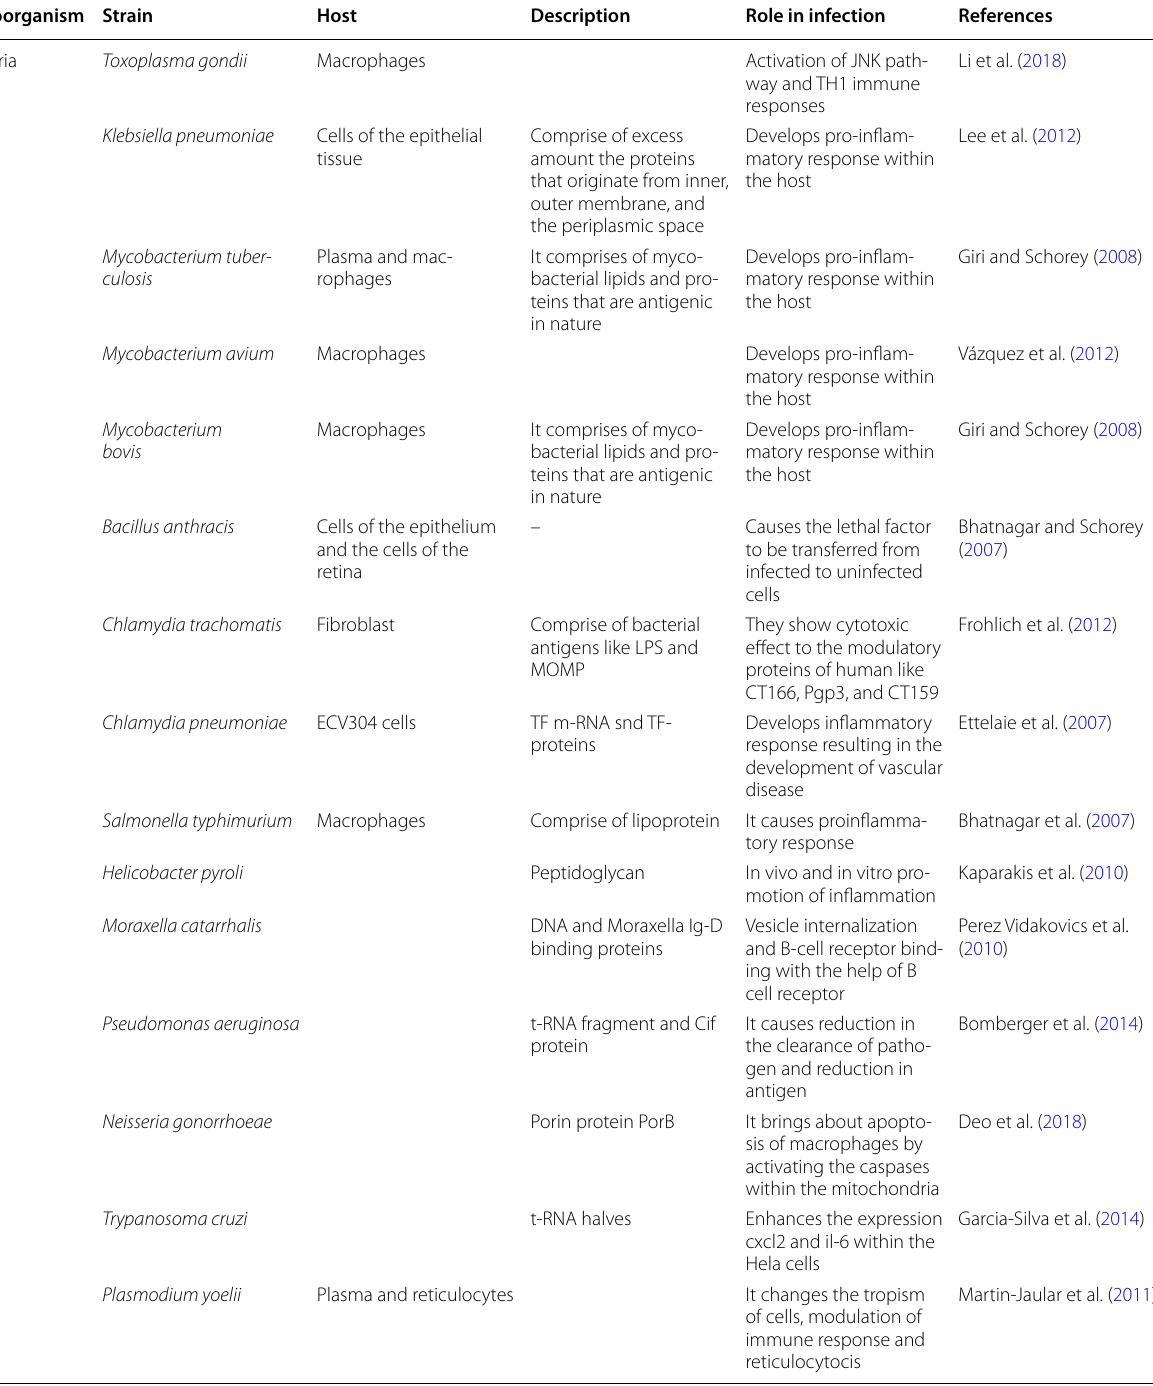
Table 1 Role of exosomes in pathogenic infections Microorganism